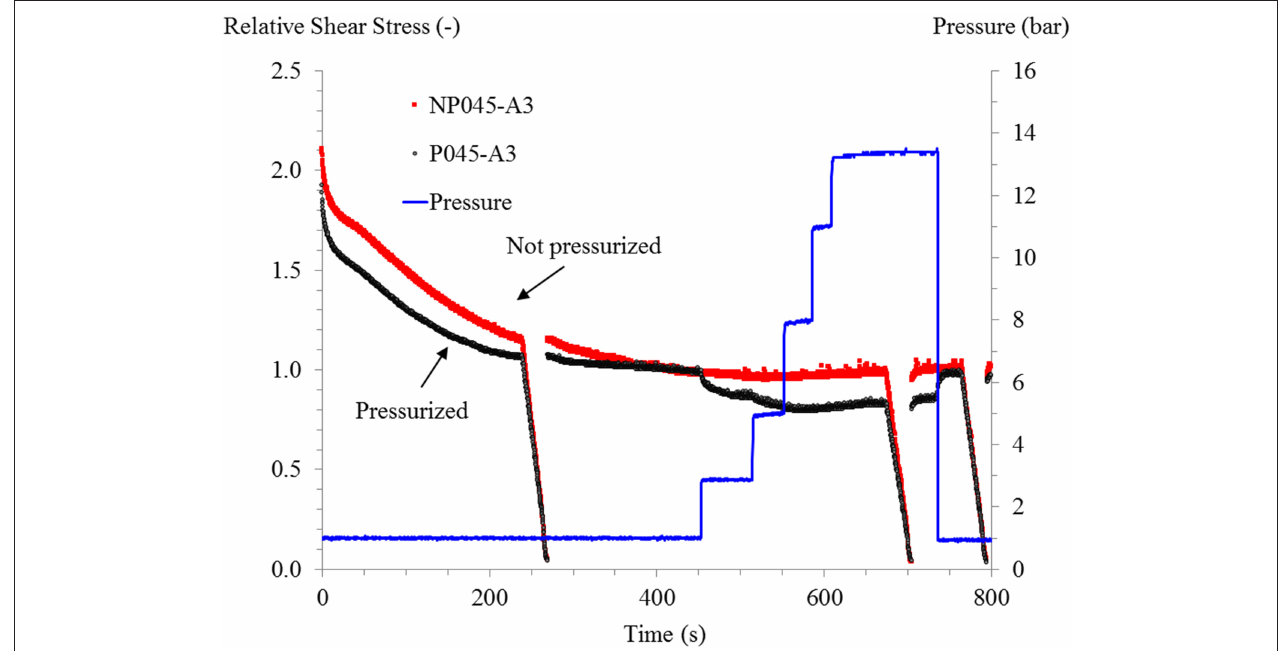
FIGURE 4 | Rheological testing procedure “A” applied on mixture P045-A3. The relative shear stress equals 1 just before the application of pressure.